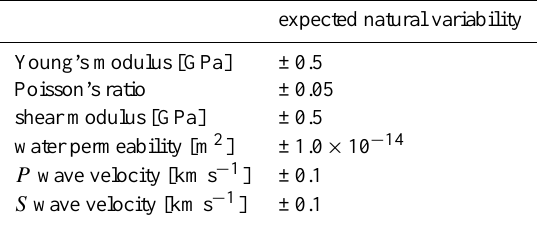
from the same block. Note that these are not “errors” in the mea- surements. Measurement accuracies (Table 2) are insignificant com- pared to the natural sample variability, despite efforts to reduce the variability between samples cored from the same block of material (see text for